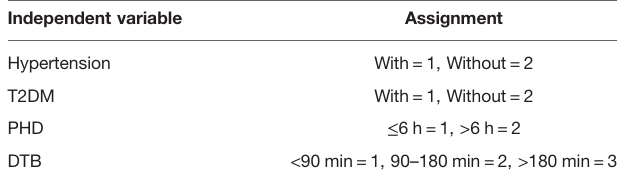
TABLE 4 | Multi-factor assignment.